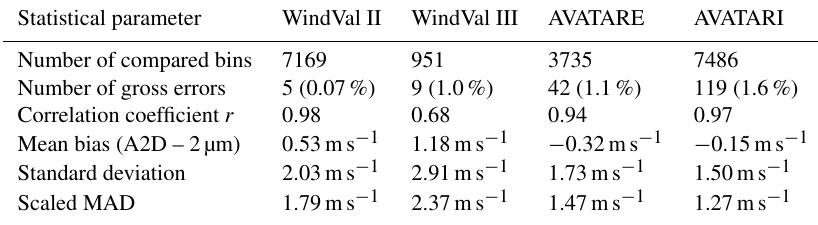
Table 3. Results in the statistical comparison between the A2D Mie and the 2µm LOS wind data obtained from the WindVal II and Wind- Val III (without retrieval improvements), as well as the AVATARE and AVATARI campaigns (with retrieval improvements). For WindVal II and WindVal III, the gross errors are defined as winds that deviate by more than 10ms − 1 from the 2µm winds. For AVATARE and AVATARI, gross errors are defined as winds that deviate by more than 4 times the scaled MAD from the 2µm winds.